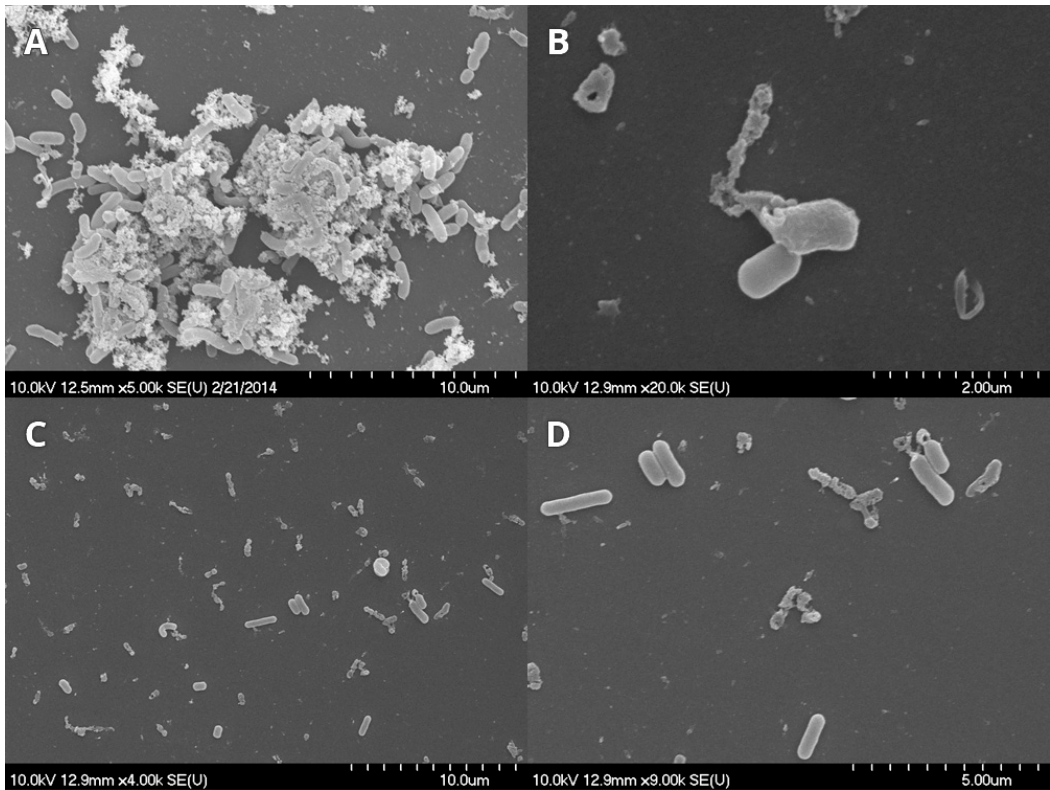
Figure4. Listeriamonocytogenes and Escherichiacoli biofilmsobservedusingscanningelectronmicroscope. Figure 4. Listeria monocytogenes and Escherichia coli biofilms observed using scanning electron ( A ) control, ( B ) thyme EOs (0.5 mg / mL), and ( C , D ) thymol (0.1 mg / microscope. A: control, B: thyme EOs (0.5 mg/mL), and C, D: thymol (0.1 mg/mL).